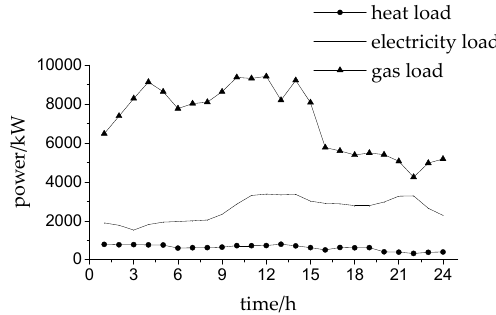
Figure 6. The curves of electricity, heating and gas loads.